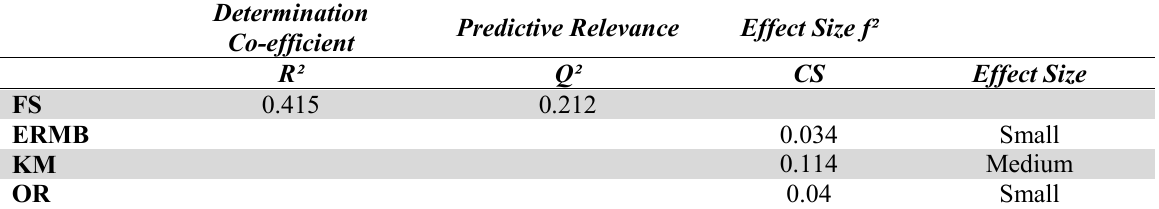
Determination of Co-efficient (R 2 ), Effect size (f 2 ) and Predictive Relevance (Q 2 )